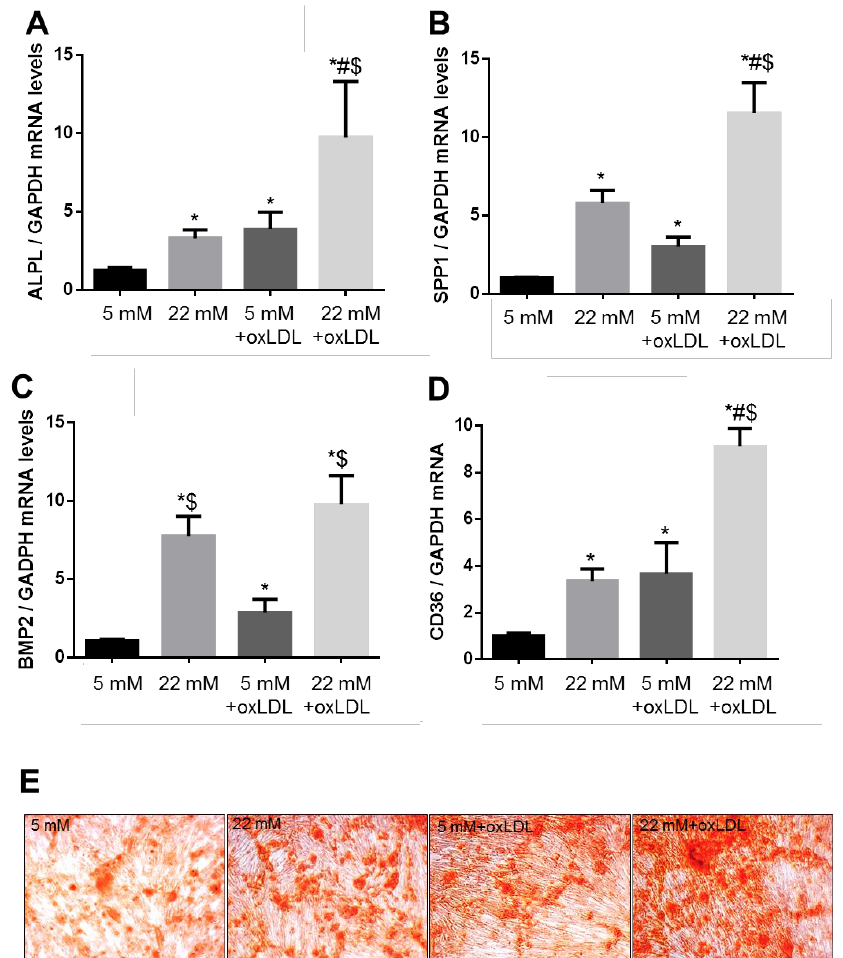
Figure 3. Calcification markers are induced in long-term exposed-VSMC to HG in the absence or presence of oxLDL. The expression of bone matrix proteins that regulate the calcification process was induced in VSMC cultured with high glucose for 7 days and co-incubated or not with oxLDL for the last 24 h. ( A – D ) Alkaline phosphatase (ALPL), secreted phosphoprotein 1 (SPP1), bone morphogenetic protein 2 (BMP2), and CD36 mRNA levels were determined by qPCR analysis and normalized to GAPDH. ( E ) Representative pictures of VSMC cultured in osteogenic medium for 7 days with NG or HG ± oxLDL and stained with alizarin red. Mean fold change relative to cultured VSMC in NG medium ± SEM ( n = 5). * p ≤ 0.05 vs. 5 mM; # p ≤ 0.05 vs. 22 mM; $ p ≤ 0.05 vs. 5 mM + oxLDL.